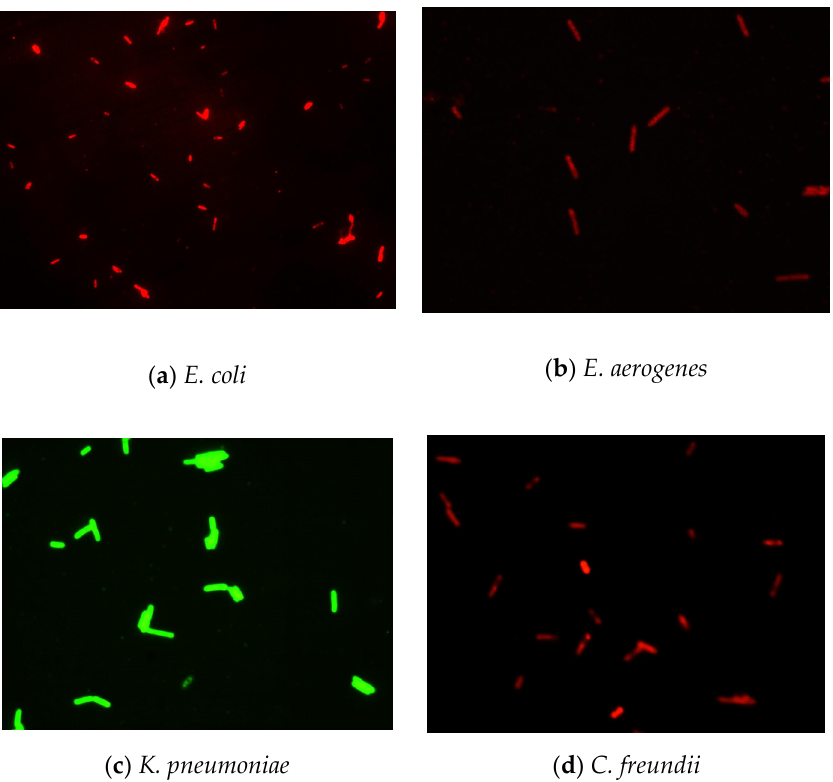
Figure 3. Identification of the optimal hybridization time for detecting coliform bacteria using FISH. E. coli ( a ) and E. aerogenes ( b ) cells were detected by FISH using specific probes for hybridization for different times at 50 °C.